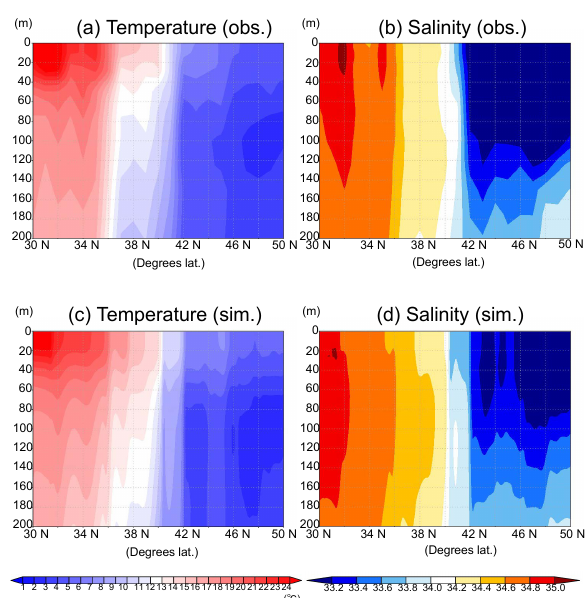
Figure 7. Vertical distribution of temperature (a, c) and salinity (b, d) along the 165 ◦ E section in June 1998. (a, b) Data in situ ob- served during 16 to 21 June in 1998 downloaded from World Ocean Database 2013. (c, d) Physical field in June 1998 mean used in the 3-D NSI-MEM.